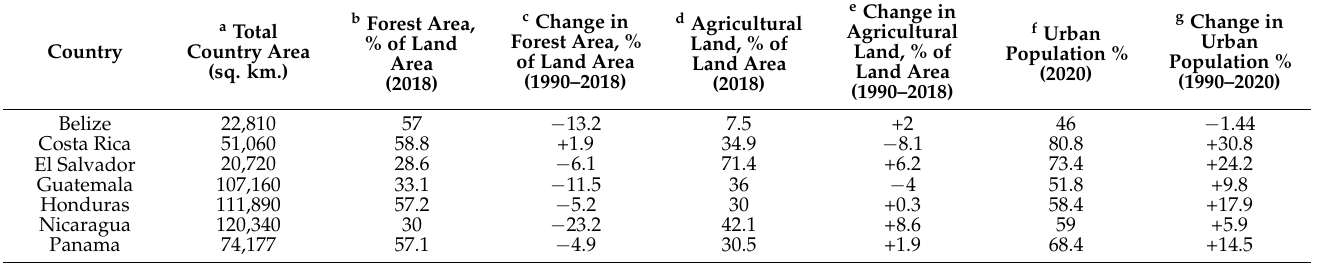
Table 1. Current proportions of forest area, agricultural land, and urban population in Central America, including changes over the last 30